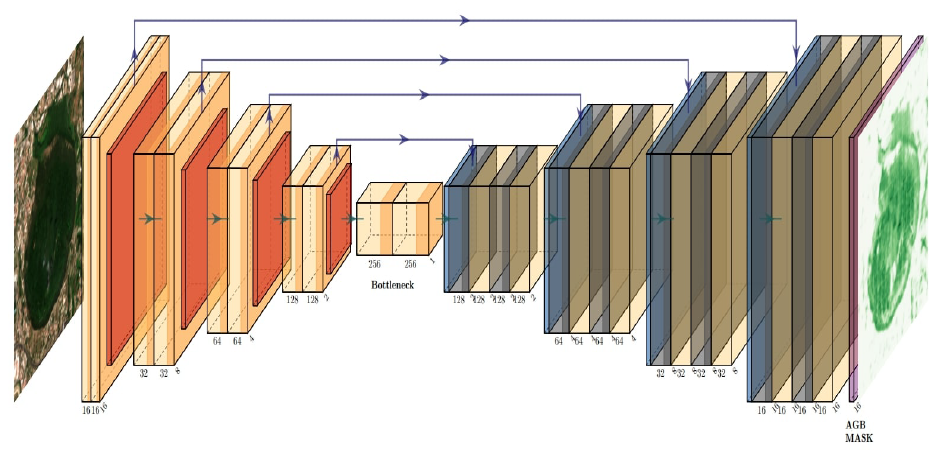
Figure 1. ReUse architecture for pixel-wise regression. The input is the Sentinel-2 image with dimensions (patch size, patch size, number of channels); the output is the AGB image with dimensions (patch size, patch size,